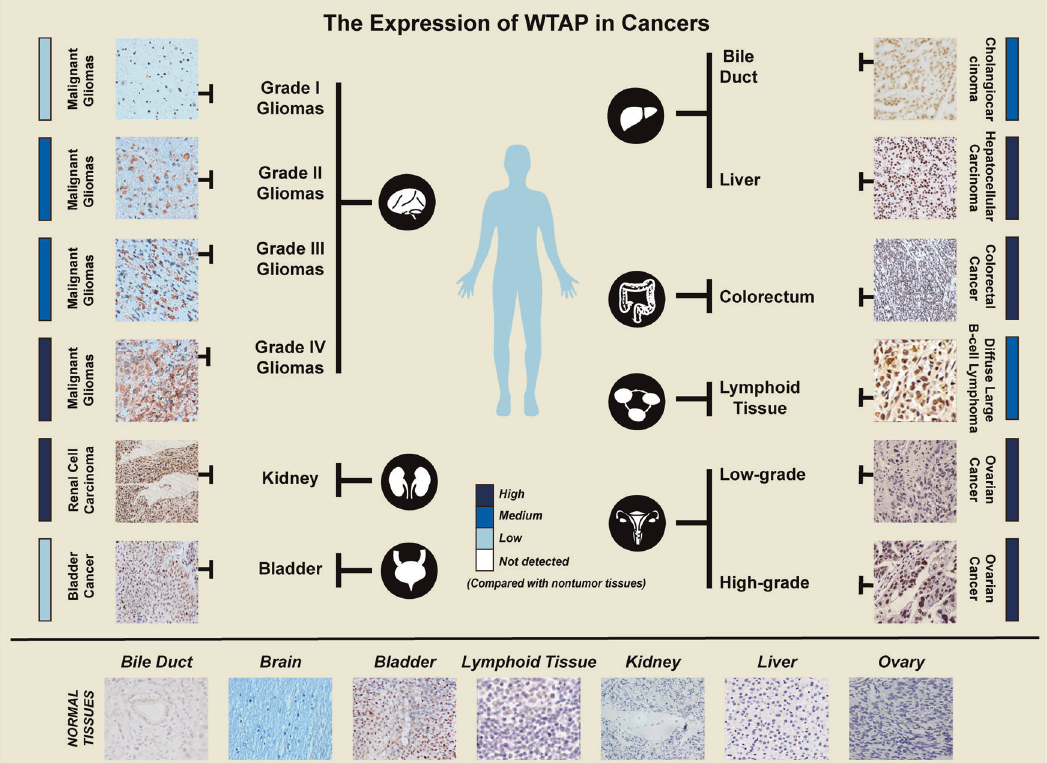
Fig. 4 The function of WTAP in biological process. Immunohistochemistry has been performed in many studies. Strong staining for WTAP was observed in grade IV gliomas, renal cell carcinoma, hepatocellular carcinoma, colorectal cancer, and high-grade ovarian carcinoma, with low staining in adjacent normal tissues.